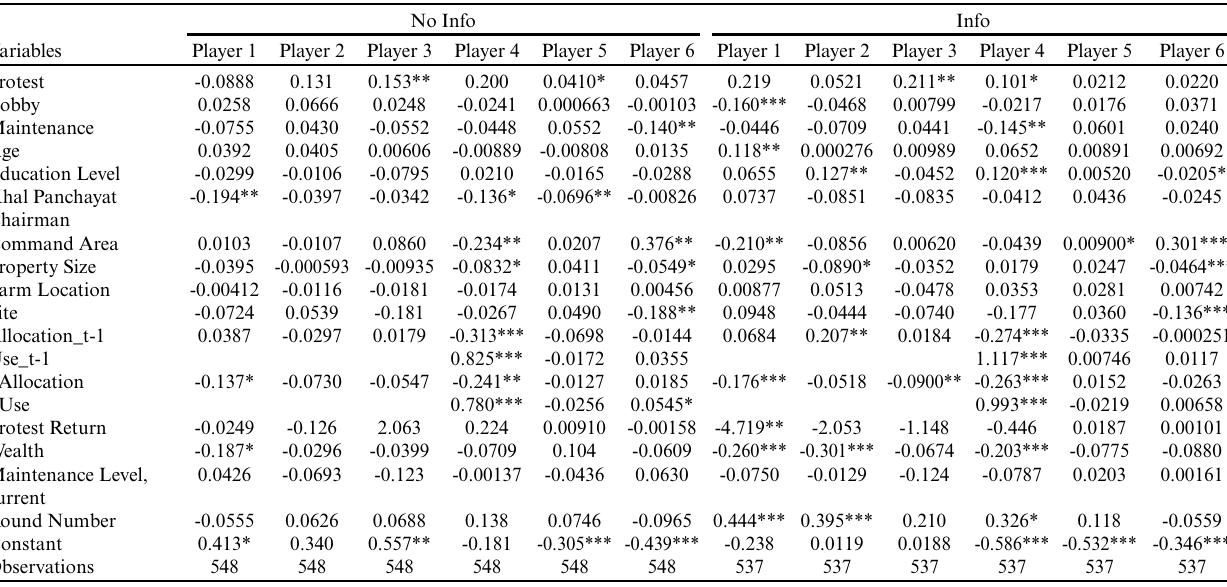
Table 4 . Player-by-player regressions: protest